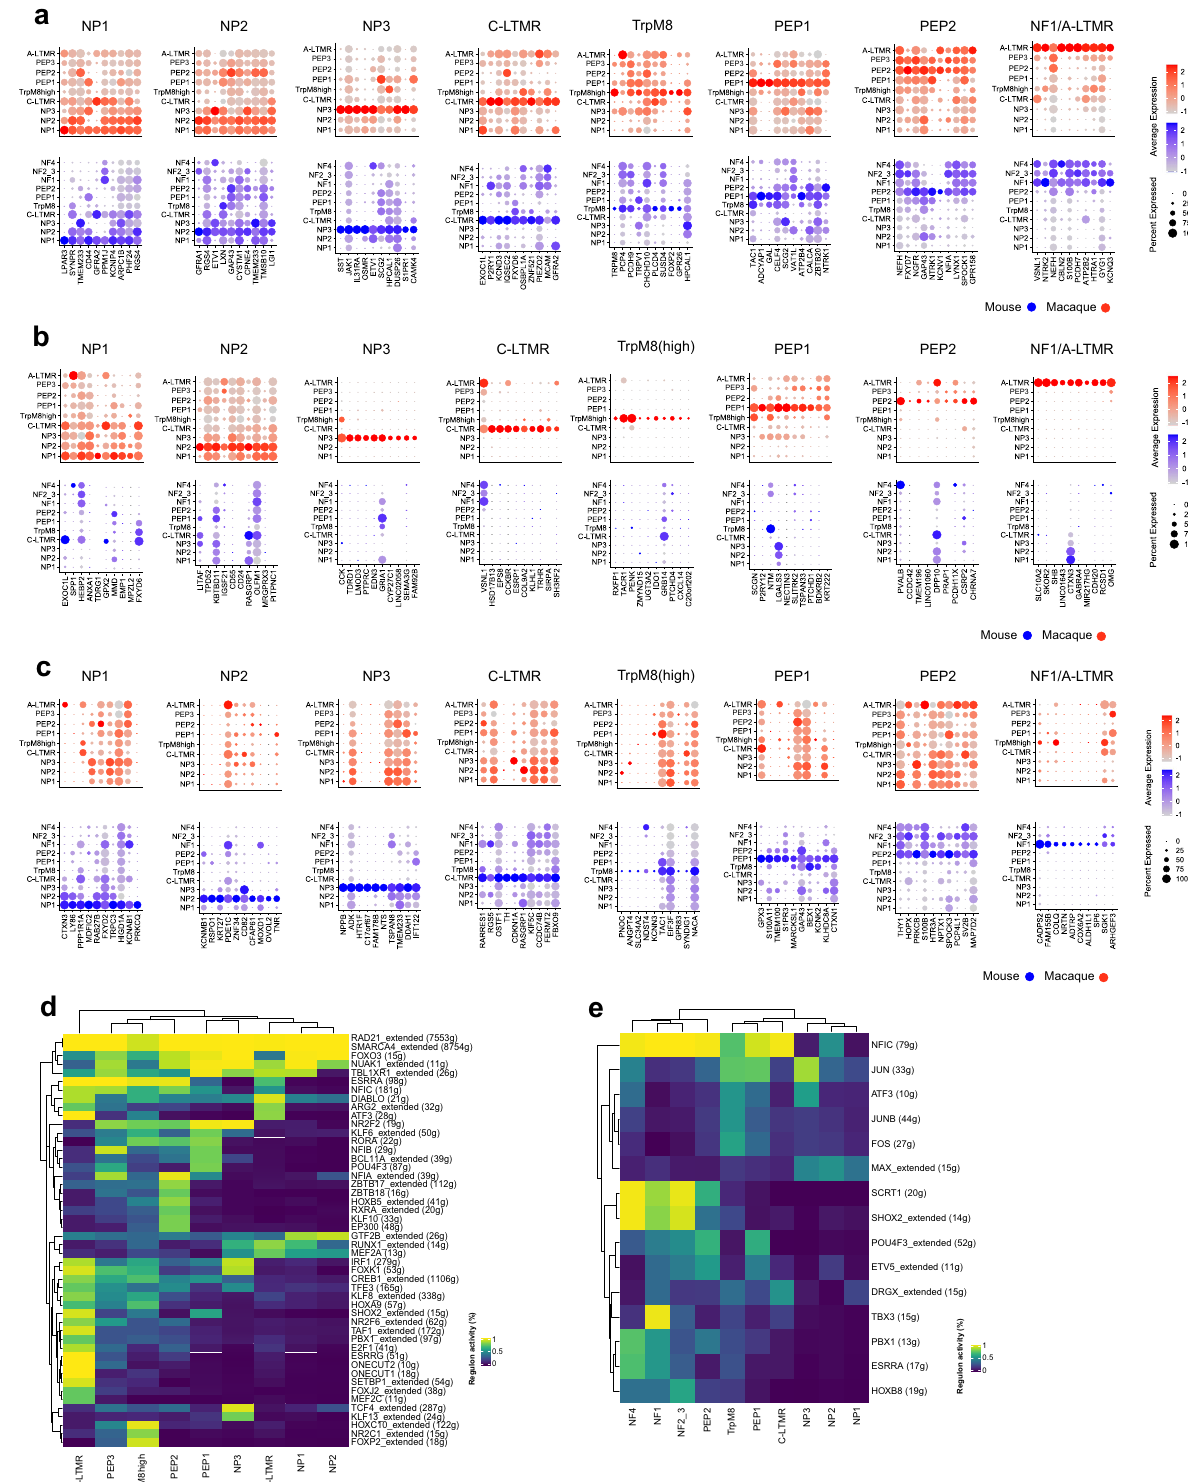
Fig. 5 Comparison of gene expression pro fi les across species. a Dot plots showing ten most speci fi c shared markers of corresponding/homologous cell types between the species. b Dot plots showing ten most macaque speci fi c markers for each corresponding cell-type pair. c Dot plots showing ten most mouse-speci fi c markers for each corresponding cell-type pair. Dot sizes in a – c correspond to the percentage of cells expressing the gene in the cluster and color scale indicates log2FC. d Heatmap showing binary regulon activity in each of the macaque DRG cell types. e Heatmap showing binary regulon activity in the mouse DRG cell types. In d , e the number of target genes is indicated in the